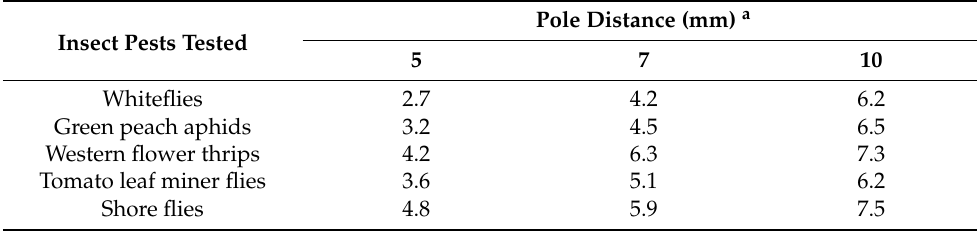
a Distance between the charged insulated conductor wire and grounded metal